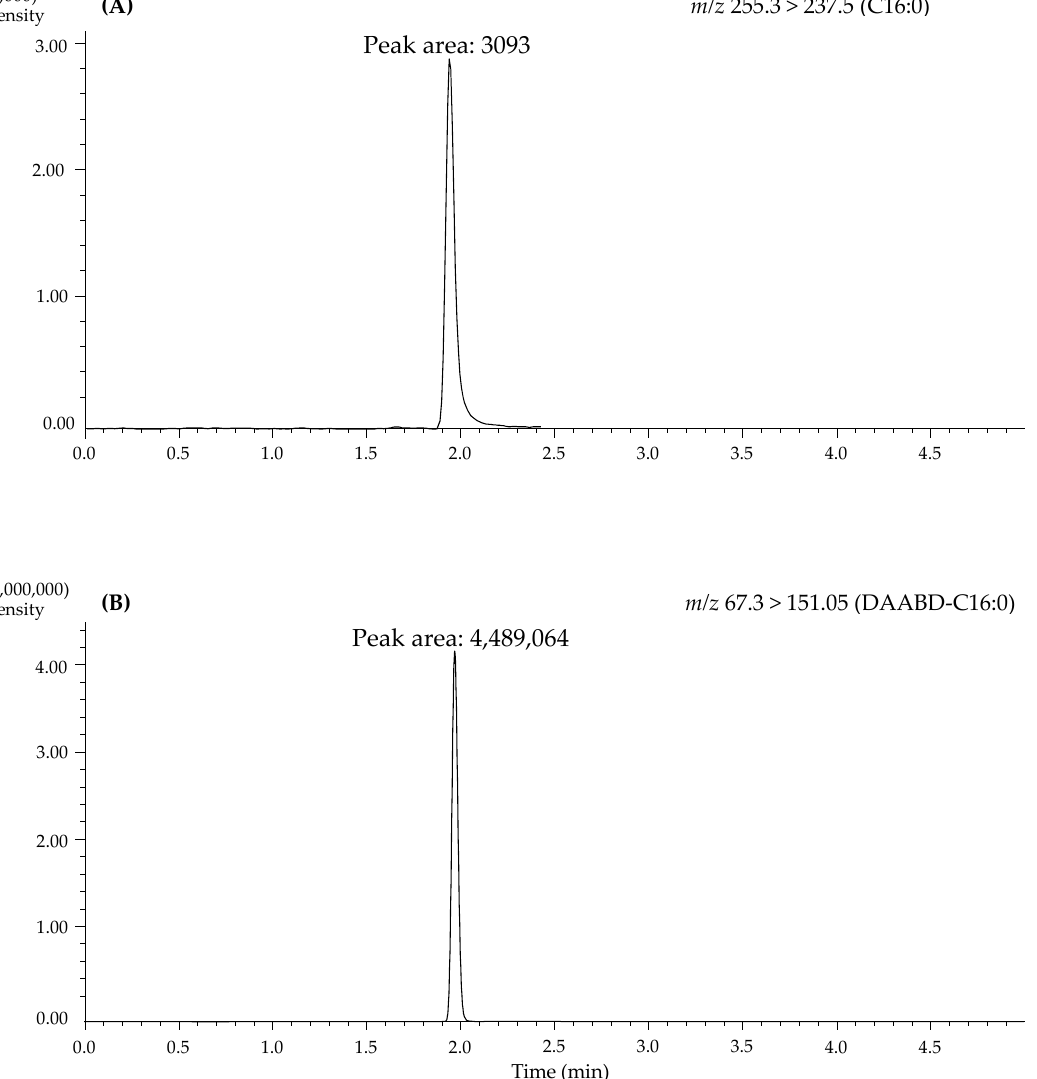
Figure 2. Extracted mass chromatograms for C16:0 free acid (2 μ g on column) in negative ion mode at m/z 255.3 > 237.5 ( A ), and DAABD-C16:0 amide derivative (5 fg on column) in positive ion mode at m/z 567.3 > 151.1 ( B ).